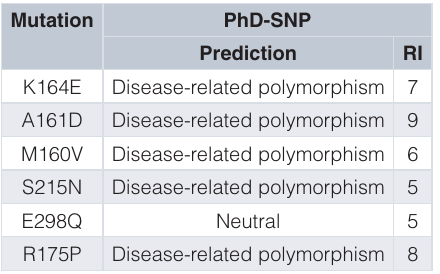
Table 7. Prediction of functionally significant nsSNPs, by PhD-SNP.